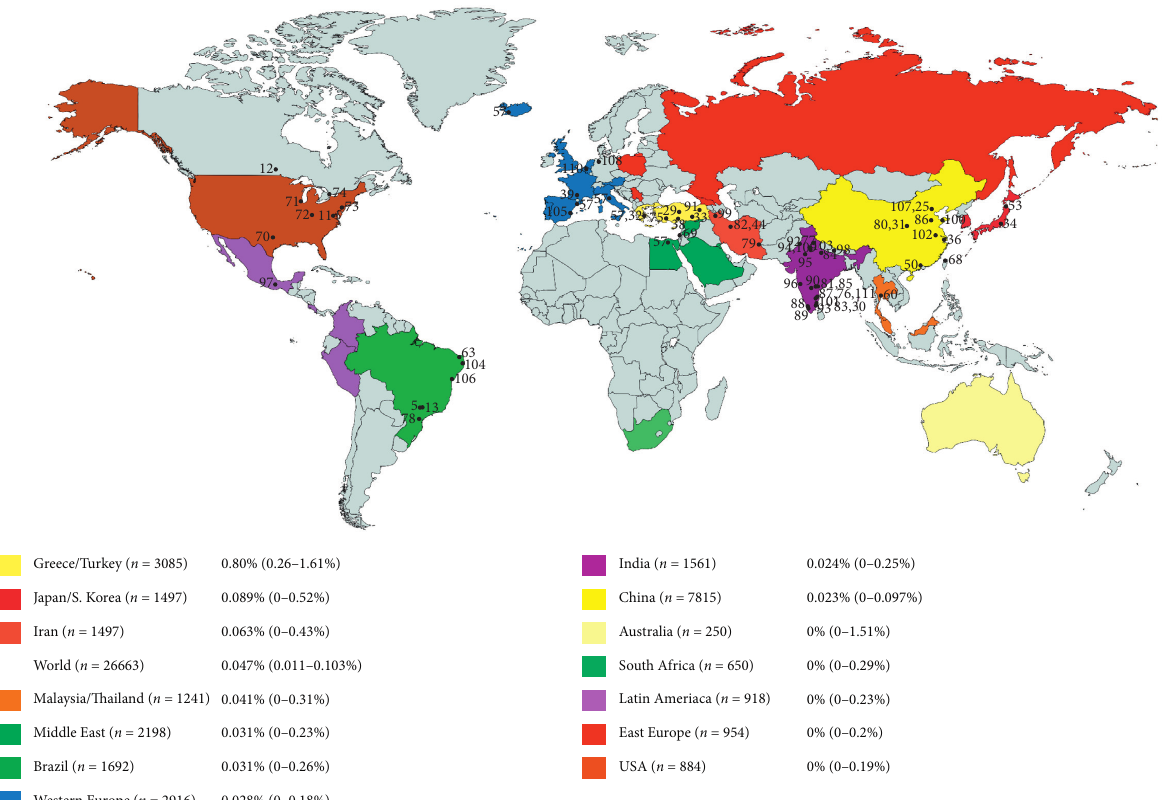
Figure 4: Global distribution of four-rooted maxillary first molars. All case reports and maxillary first molars with four roots identified in CBCT studies were marked on the world map. The regional differences in the occurrence rate were noted.